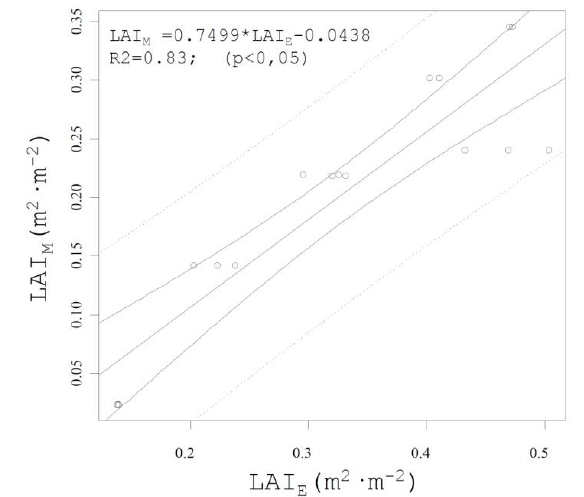
Figure 13. Relationship between estimated leaf area index ( LAI return density and leaf area manually measured ( LAI ( Cabernet Sauvignon and Merlot ) included in this